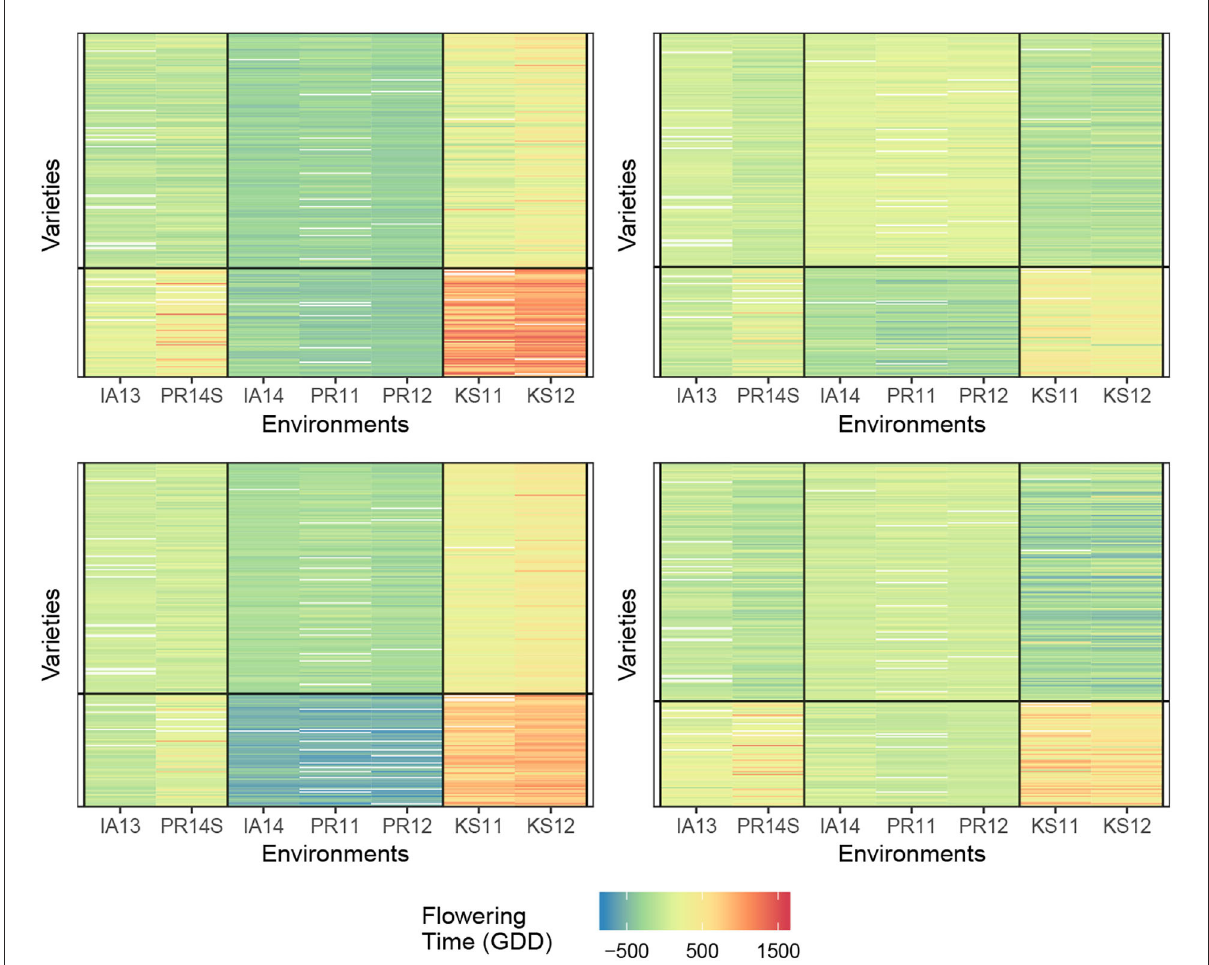
FIGURE2 Comparison of biclusterings plots for sorghum. The homogeneity of the cells indicates that the biclustering algorithm was able to successfully group the response variables in distinct clusterings. Top left—response (1); Top right—response (2); bottom left—response (3), and bottom right—response